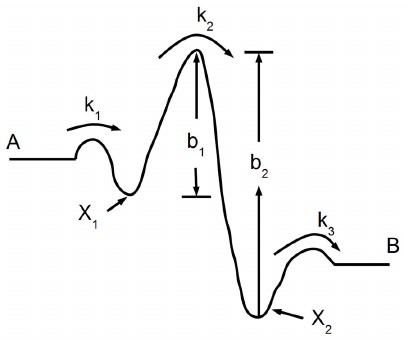
Figure 1. The canonical energy landscape for an enzymatic reaction. X 1 is the bound state representing the enzyme - substrate complex; X 2 represents the enzyme - product complex.